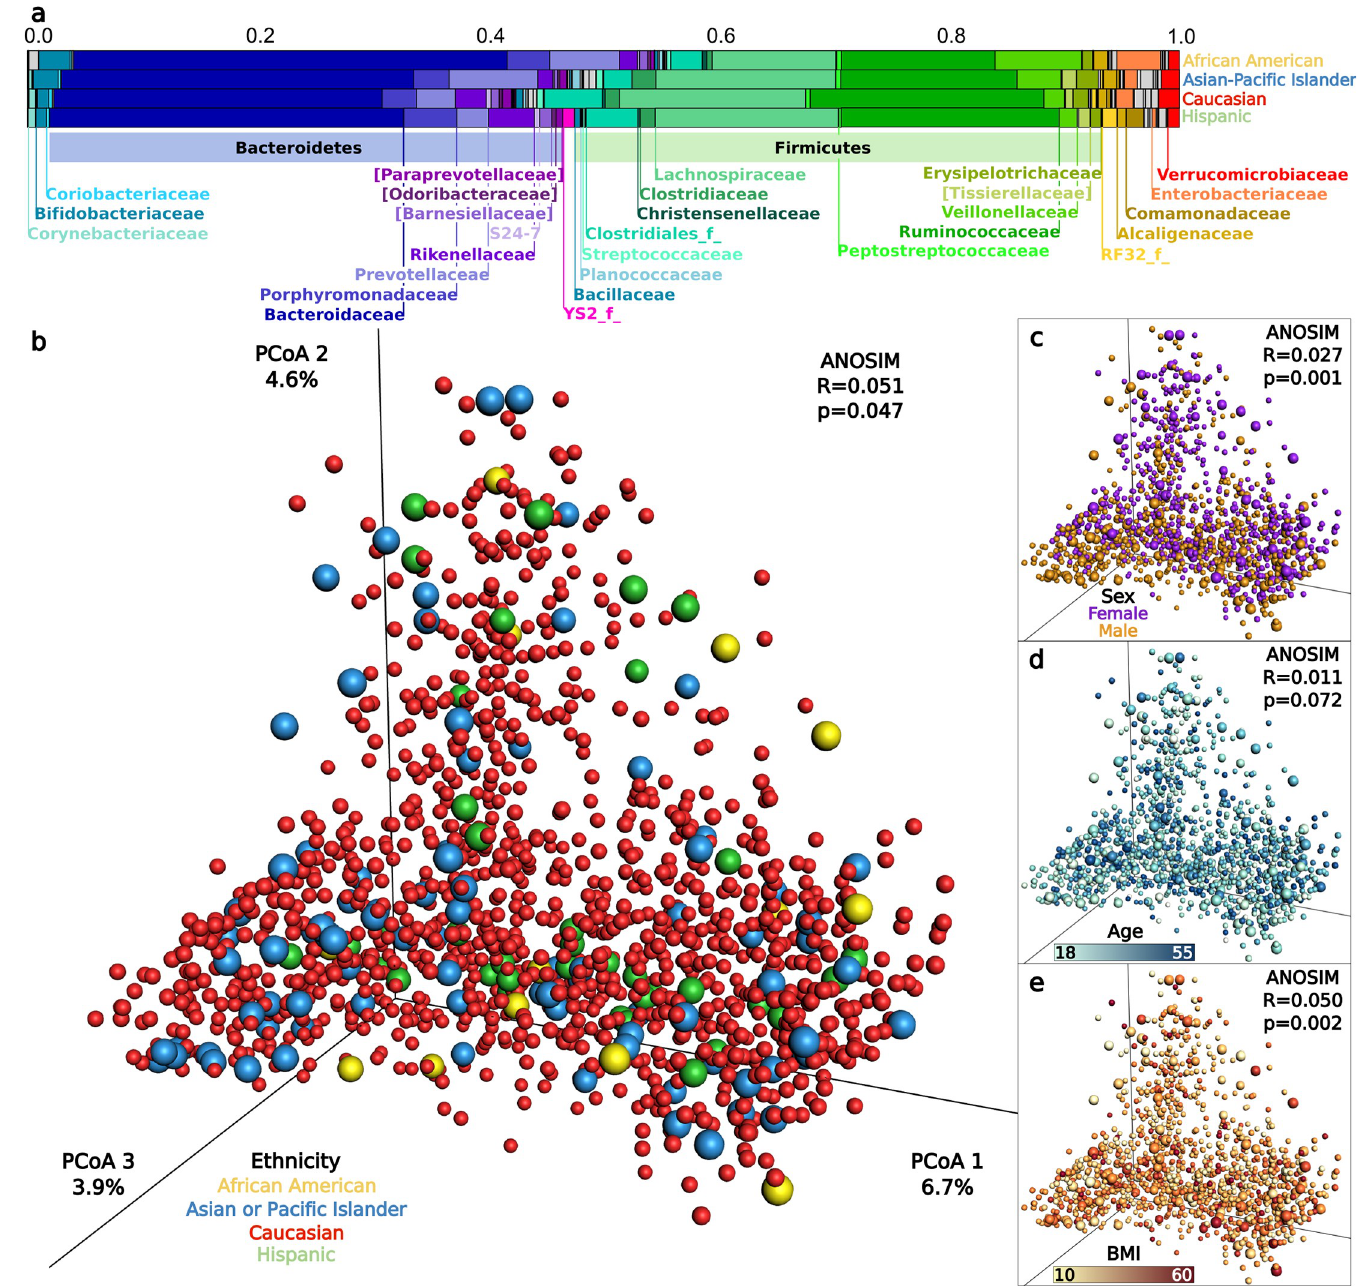
Fig 1. Gut microbiota composition and distinguishability by ethnicity, sex, age, and BMI. (A) The average relative abundance of dominant microbial families for each ethnicity. (B–E) Principle coordinates analysis plots of microbiota Bray–Curtis beta diversity and ANOSIM distinguishability for: (B) Ethnicity, (C) Sex, (D) Age, (E) BMI. In B–E, each point represents the microbiota of a single sample, and colors reflect metadata for that sample. Caucasian points are reduced in size to allow clearer visualization, and p -values are not corrected across factors that have different underlying population distributions. Data available at https://github.com/ awbrooks19/microbiota_and_ethnicity. BMI, body mass